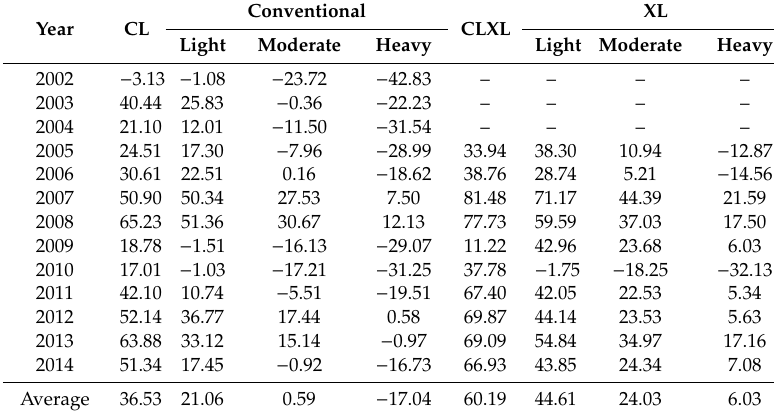
hybrid (CLXL) rice under the light, moderate, and heavy levels of initial red rice infestation: